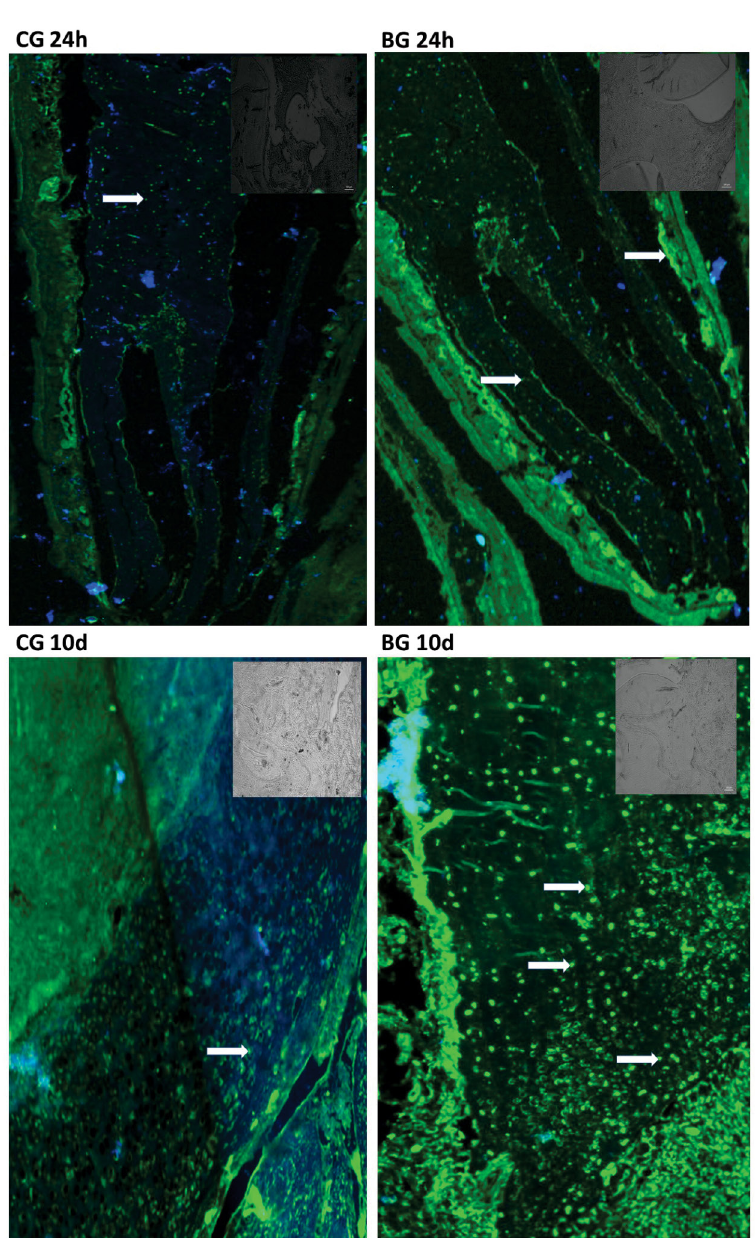
Figure 3- Confocal photomicrographs representative of immunoreactivity to osteocalcin: CG 24h (control group 24 hours); CG 10d (control group 10 days); BG 24h (bleached group 24 hours); BG 10d (bleached group 10 days). The fluorescent labeling of the Alexa-Fluor 488® secondary antibody directed to the primary anti-osteocalcin antibody is observed in green. Nuclear labeling of the inflammatory cells with DAPI is observed in blue. Arrow= osteocalcin; samples were counterstained with DAPI nuclear counterstained (blue). CG24h, BG 24h and CG 10d: Weak osteocalcin labelling (white arrows); BG10d: osteocalcin labelling (white narrow) was diffuse and strong. Scale bar, 100 mm, 10x. Small pictures - upper right: IgG